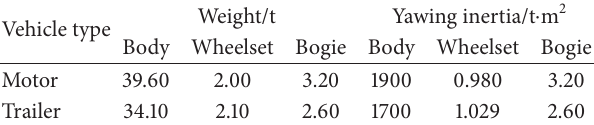
Table 1: Basic parameters of